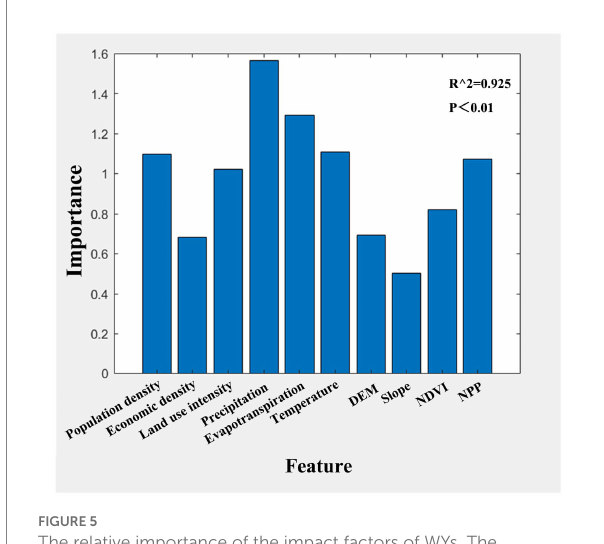
FIGURE 5 The relative importance of the impact factors of WYs. The importance value has no substantive meaning and can be used for